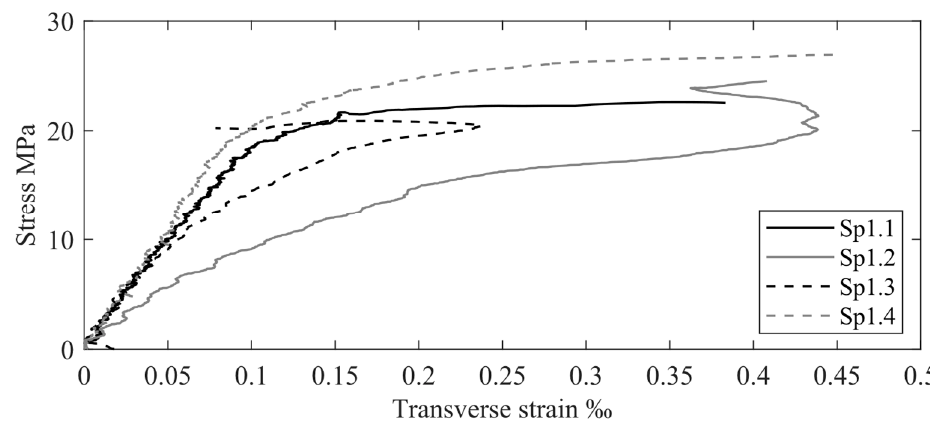
Figure 5. Experimental dependences σ c vs. ε trans .